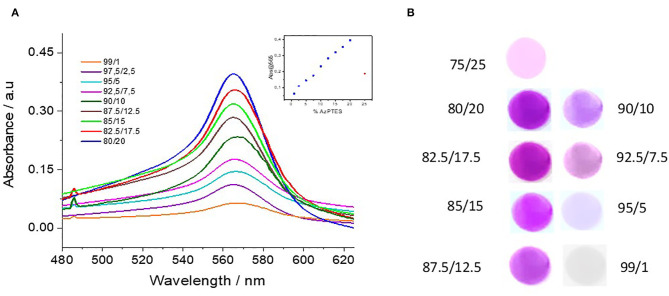
(A) Evolution of the spectra of the MLCT absorption band at 565 nm as a function of the % AzPTES in the starting film (insert: variation of the intensity of the absorption band at the maximum located at 565 nm). (B) Photographs of the Fe(tpy)2-functionalized silica thin films prepared from distinct TEOS/AzPTES ratios in the starting sol.